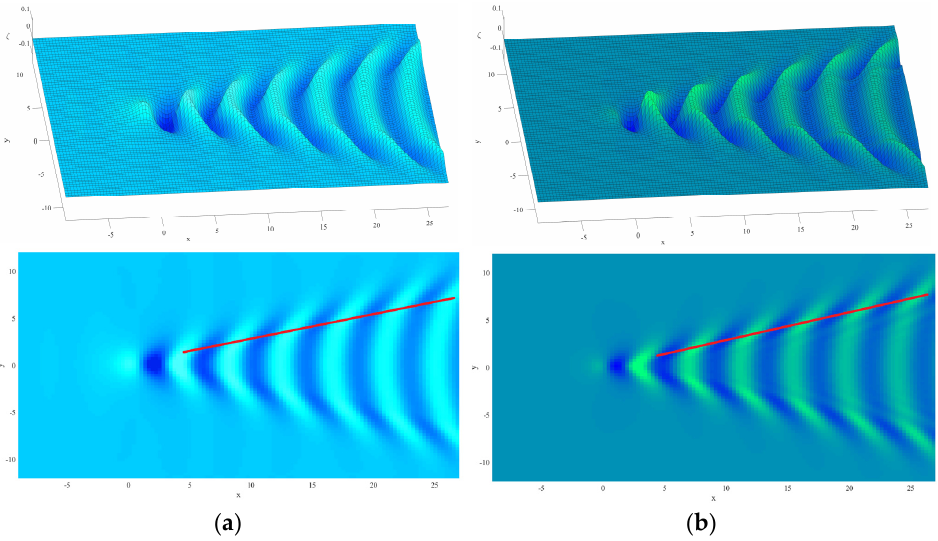
Figure 11. Perspectives and plans view of the free surface computed for F (cid:48) = 0.8: ( a ) Kelvin source with (cid:101) (cid:48) = 0.9; ( b ) Rankine source with µ (cid:48) = 0.5. The top two free surface patterns are the perspectives and the bottom two free surface patterns are the plans. The red line marks the edge of the wake angle in each plan